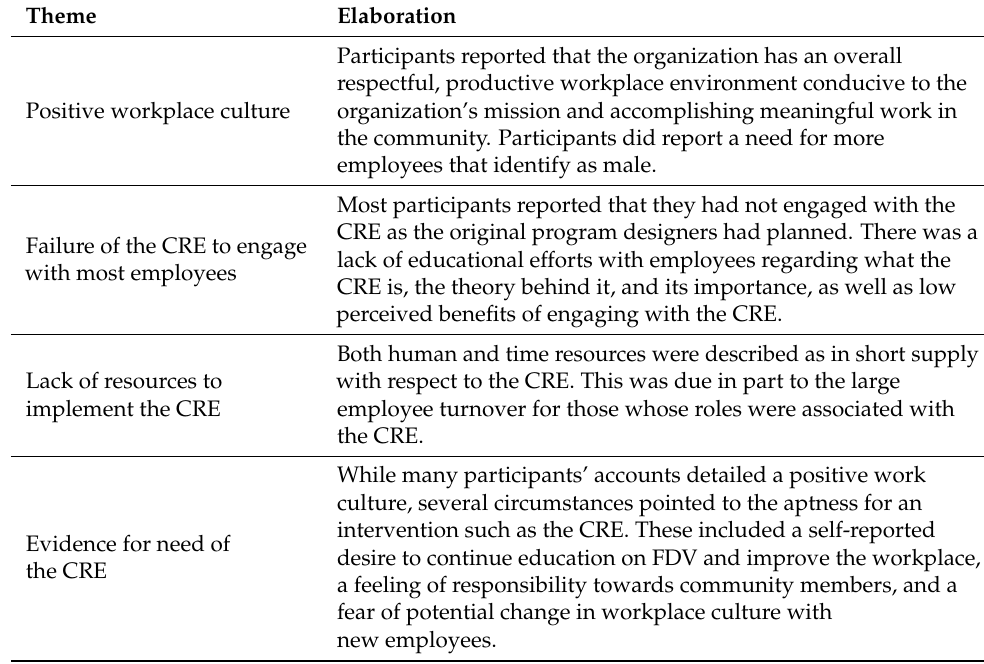
Table 1. Key themes